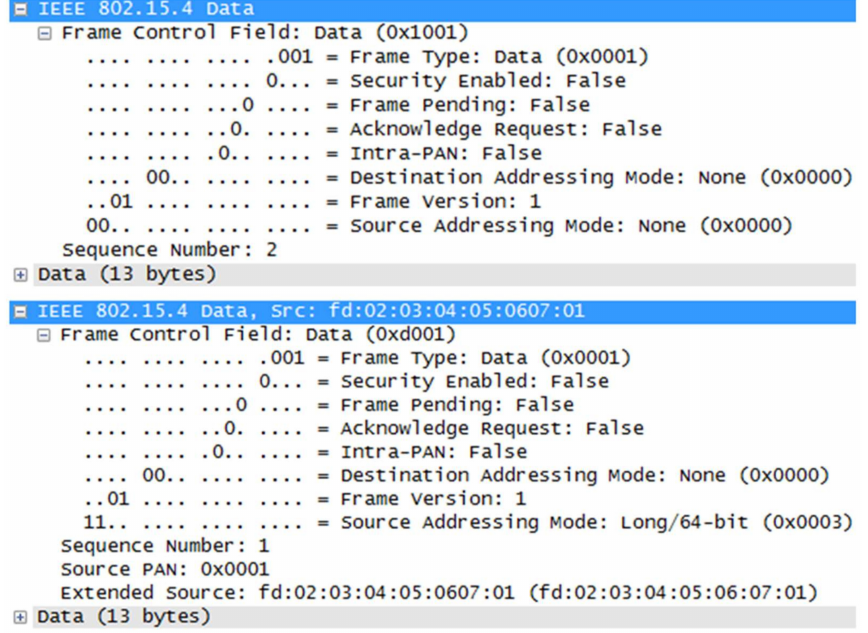
Figure 6. Solicitation message of ISA 100.11a standard ( top ) and case C ( bottom ). Solicitation message of ISA 100.11a standard does not include any address. However, case C needs the source address of the solicitation device for access control; thus, this message has compatibility issues with the ISA 100.11a